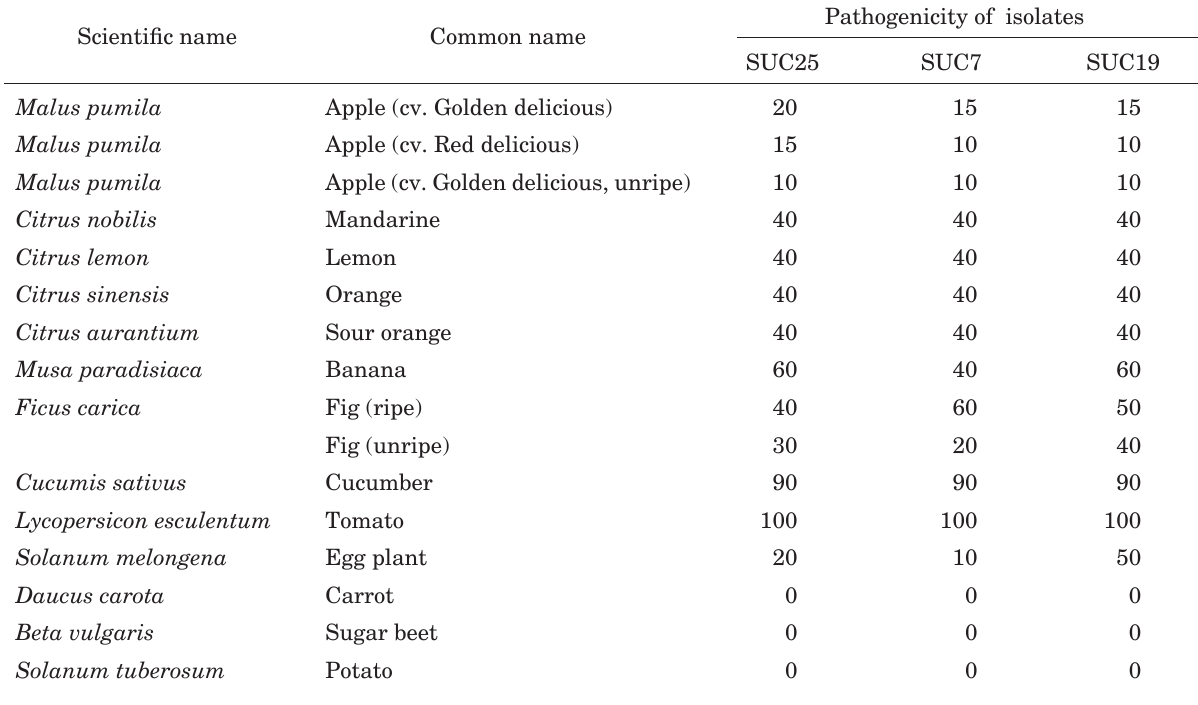
Table 5. Percentage infection of various fruits, roots and tubers of different plants by Phytophthora parsiana isolates 5 days after